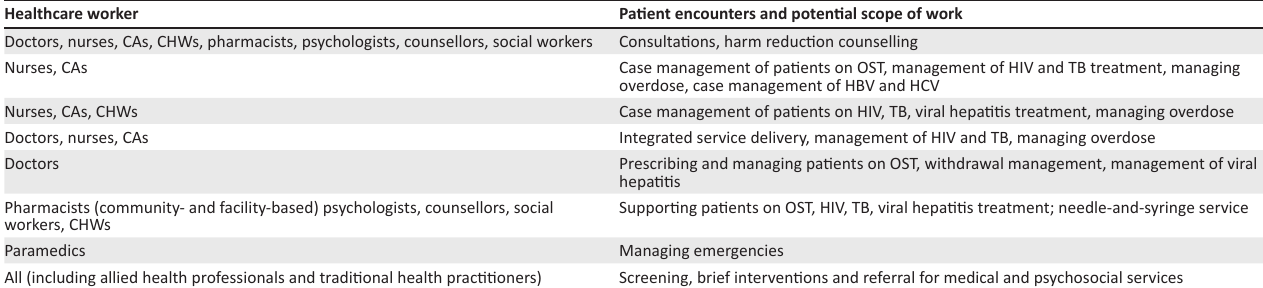
TABLE 11: Who should screen, provide brief interventions for substance use and refer for care. Healthcare